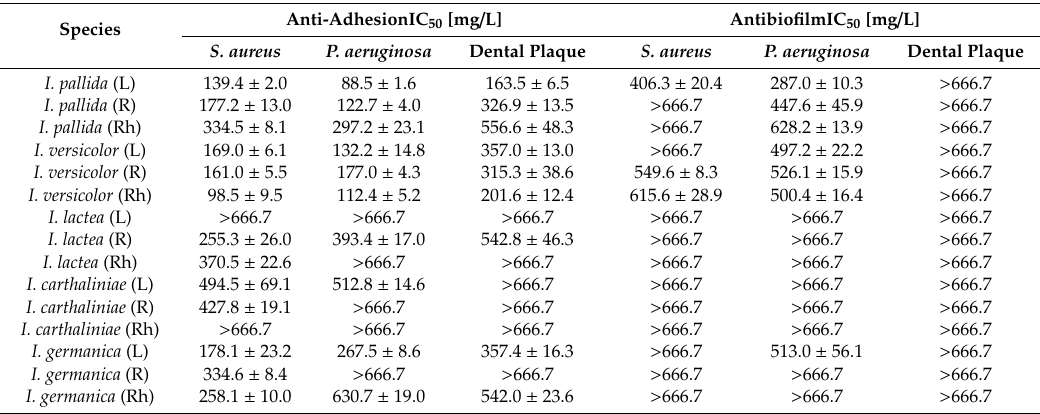
Table 2. Concentration of Iris spp. extract halving respective activity: (1) adhesion of bacteria forming biofilm and (2) mature